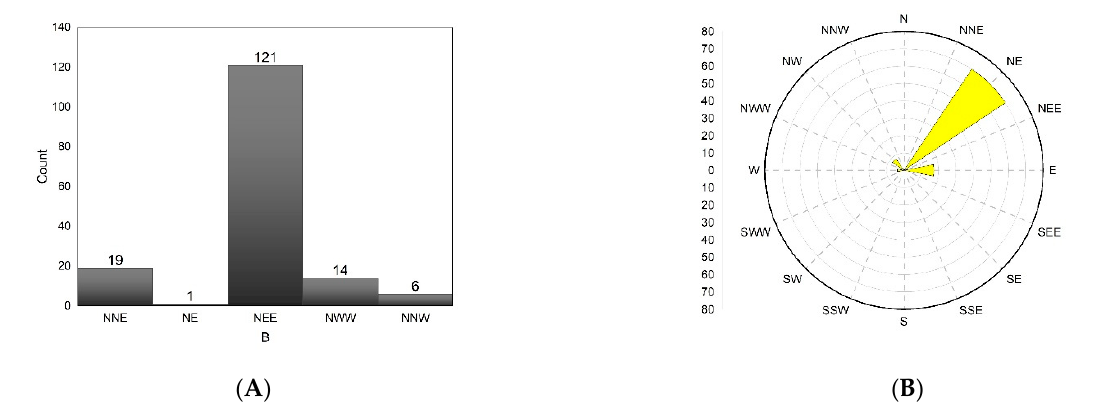
Figure 8. ( A ) Linear tectonic strike statistical histogram; ( B ) Linear tectonic strike rose diagram.